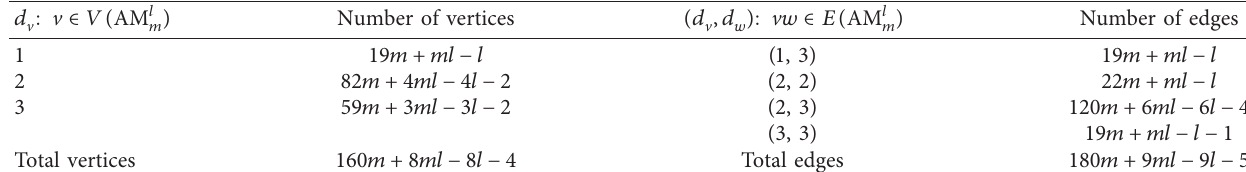
Table 7: Partitioning of the edge set with respect to the degree of end vertices for AM l